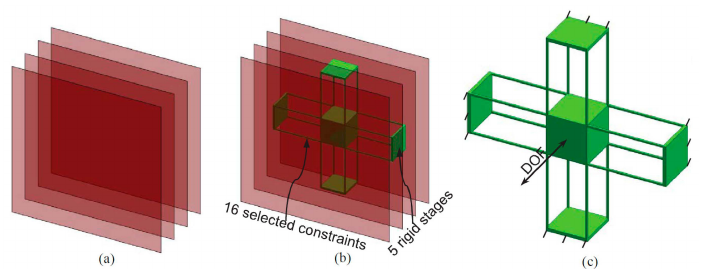
Figure 2. PM design based on the freedom and constraint topology approach: ( a ) the selectable constraints, ( b ) constraint selection and ( c ) the designed PM and its DOF.